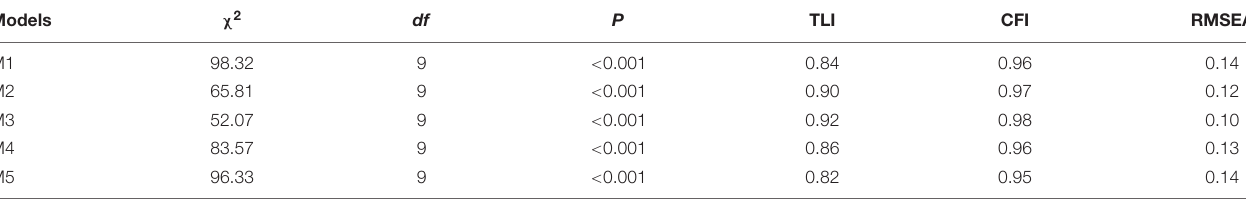
TABLE 3 | Fit statistics for the model comparison of cross-lagged associations among the Big Five personality traits, maladaptive cognitions, and Internet addiction.